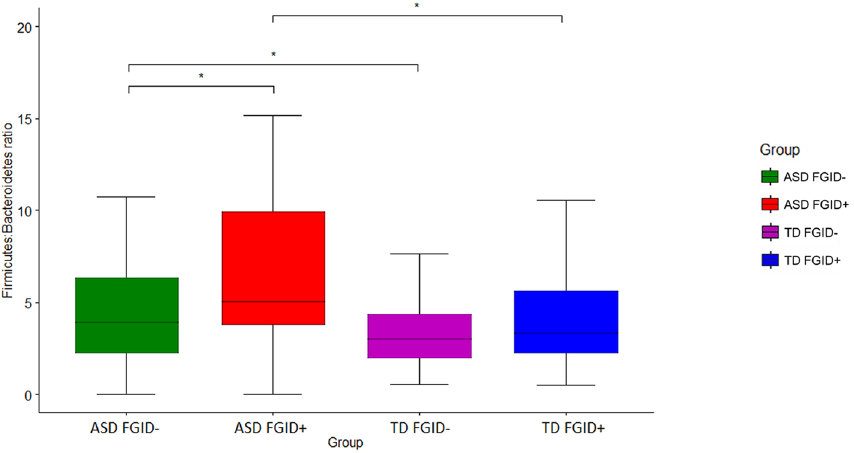
Figure 2. Comparison of the Firmicutes: Bacteroidetes ratio between ASD FGID−, ASD FGID+, TD FGID−, and TD FGID+; *p < 0.05, **p < 0.01, ***p < 0.001, ****p <